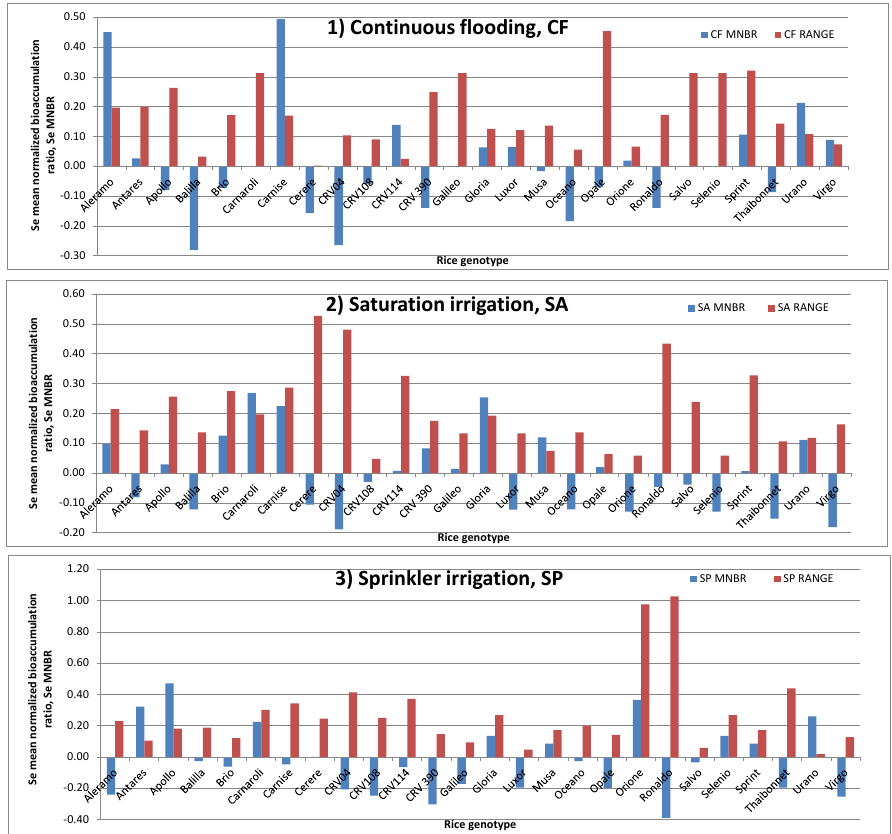
Figure 1. Behavior of the mean normalized bioaccumulation ratio of Se (Se MNBR) and range of the normalized bioaccumulation ratio of Se (RANGE) along two years in rice grains of 26 genotypes irrigated ( 1 ) by continuous flooding, CF; ( 2 ) by saturation, SA and ( 3 ) by sprinkler, SP.